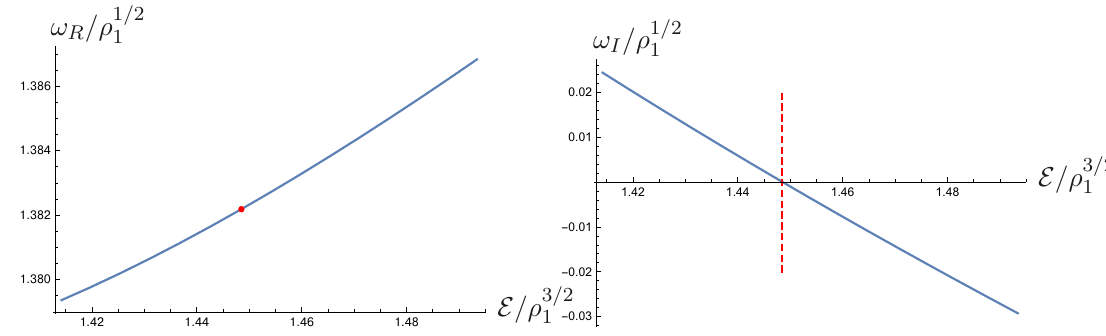
Figure 3 . The spectrum of the U(1) R symmetry breaking fluctuations at vanishing spatial mo- mentum as a function of the energy density . The red dot (left panel) represents µ 1 at critical E energy density, see (2.20); the vertical red dashed line (right panel) represents the critical energy density, see (2.27).